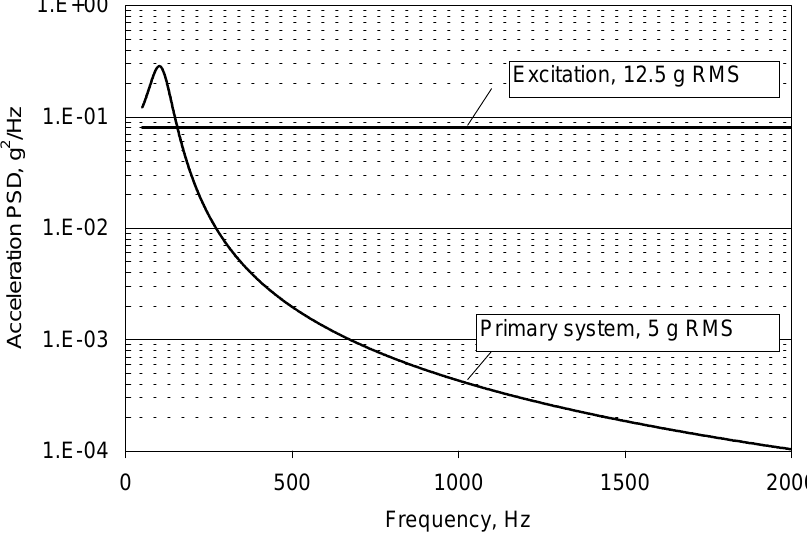
Fig. 10. Excitation and dynamic response of the optimised vibration isolator.